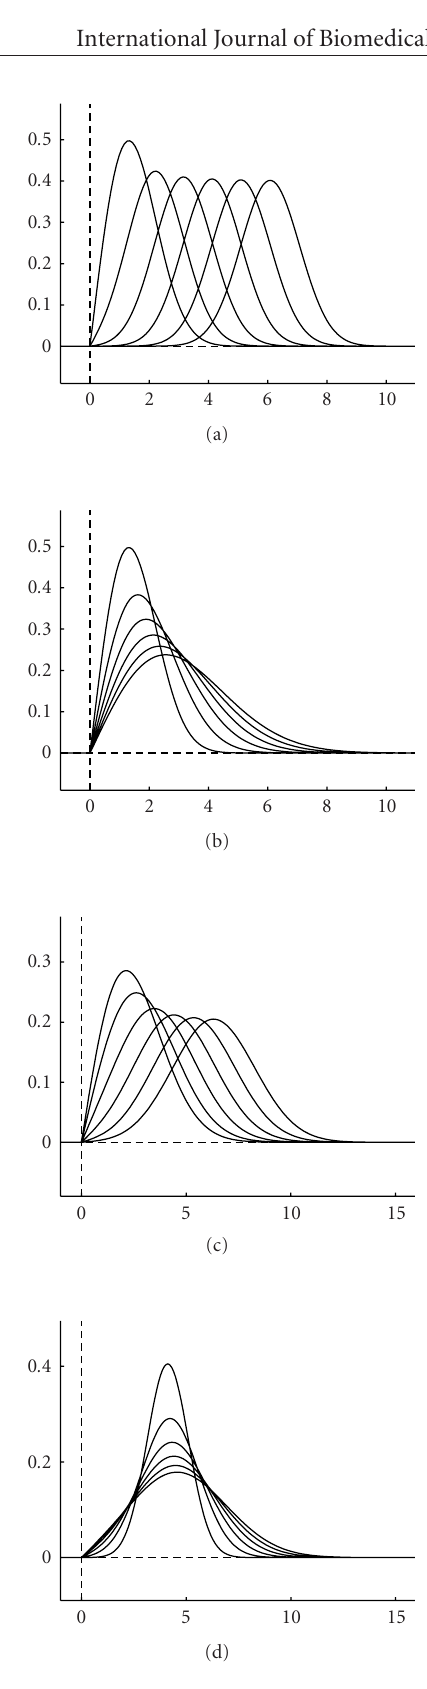
Figure 1: (a) Rician PDFs for σ 2 = 1 and A ∈ { 1, ... ,6 } , (b) Rician PDFs for A = 1 and σ 2 r ∈ { 1, ... ,6 } , (c) Rician PDFs for σ 2 = 4 and A ∈ { 1, ... ,6 } , (d) Rician PDFs for A = 4 and σ 2